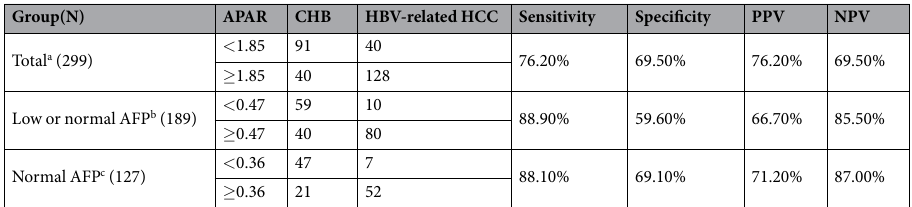
Table 3. Accuracy of the APAR index in predicting HBV-related HCC in different cohorts of participants. a Total cohort includes patients with CHB and HBV-related HCC in the training and the validation set. b Participants with low or normal AFP includes CHB patients and HBV-related HCC in the whole set of participants with AFP < 100 ng/mL. c Participants with low AFP includes CHB patients and HBV-related HCC in the whole set of participants with AFP < 20